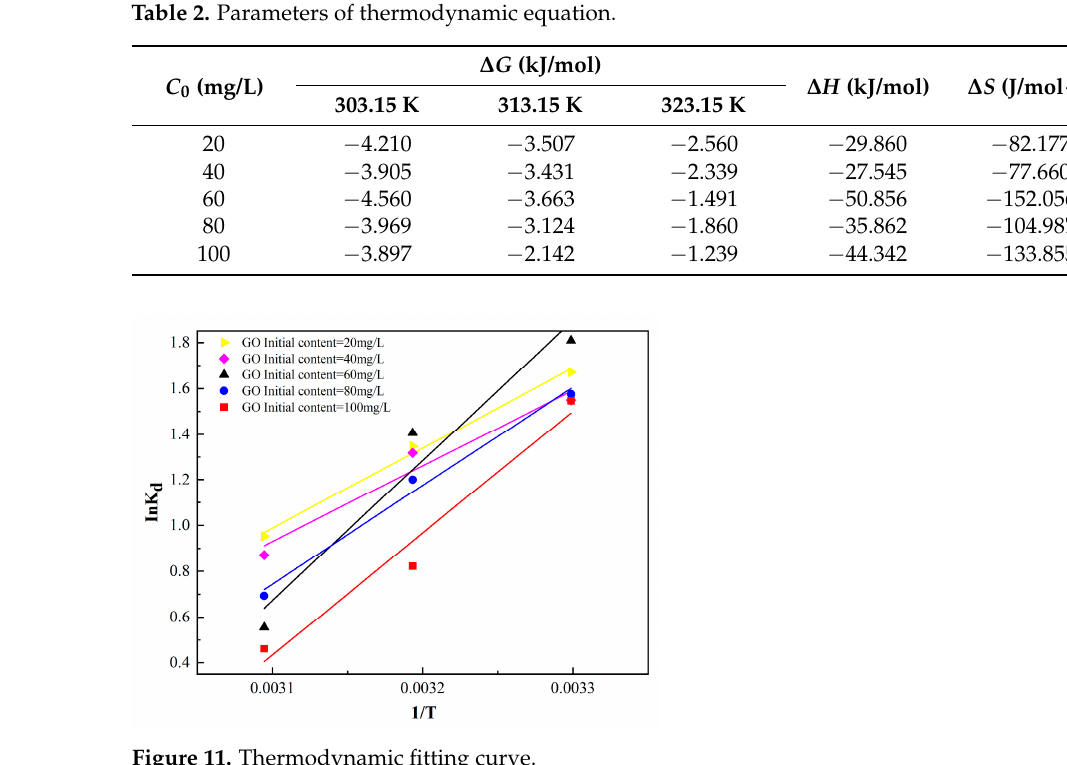
Figure 11. Thermodynamic fitting curve.